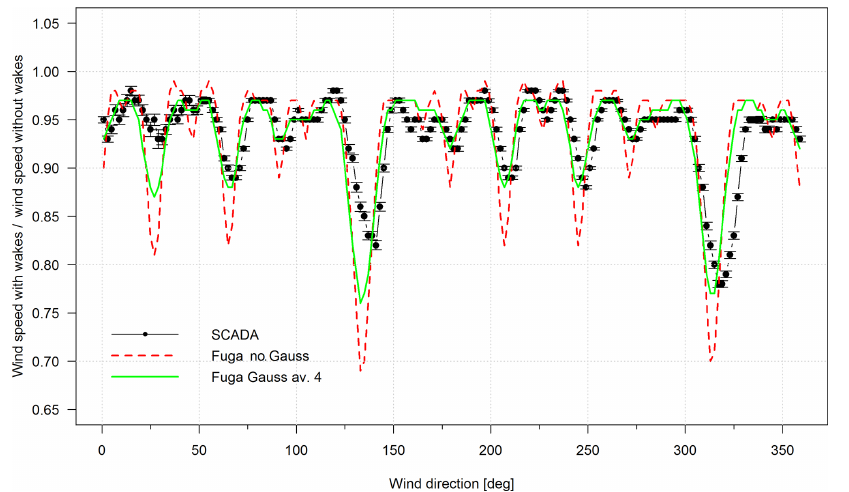
Figure 7. Wind-farm-averaged wind speed with wake effects normalized, with wind-farm-averaged wind speed without wake effects plotted versus averaged wind farm wind direction. Black dots show the measurements from SCADA, and the green solid line represents the results from Fuga with a Gauss averaging for a standard deviation of 4 ◦ . An offset of the wind direction between the model and SCADA can be observed. At 207 ◦ the offset is approximately 2.2 ◦ , and it increases up to 5 ◦ for wind directions (132 and 312 ◦ ) with the largest wake effects. An explanation and correction for this wake drift is proposed in Sect. 2.2.